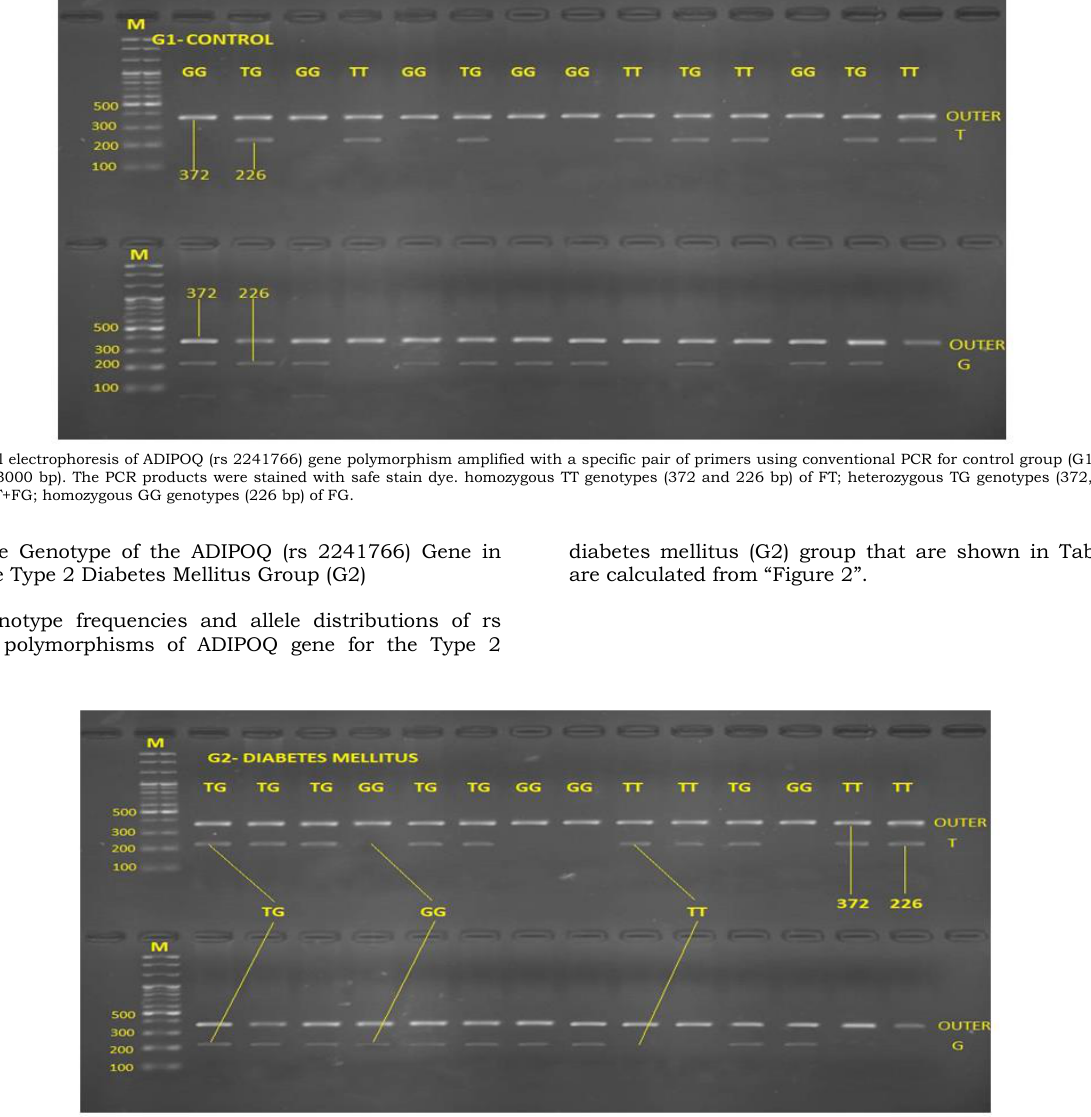
Table 2 Size of bands of ADIPOQ (rs 2241766) gene polymorphism